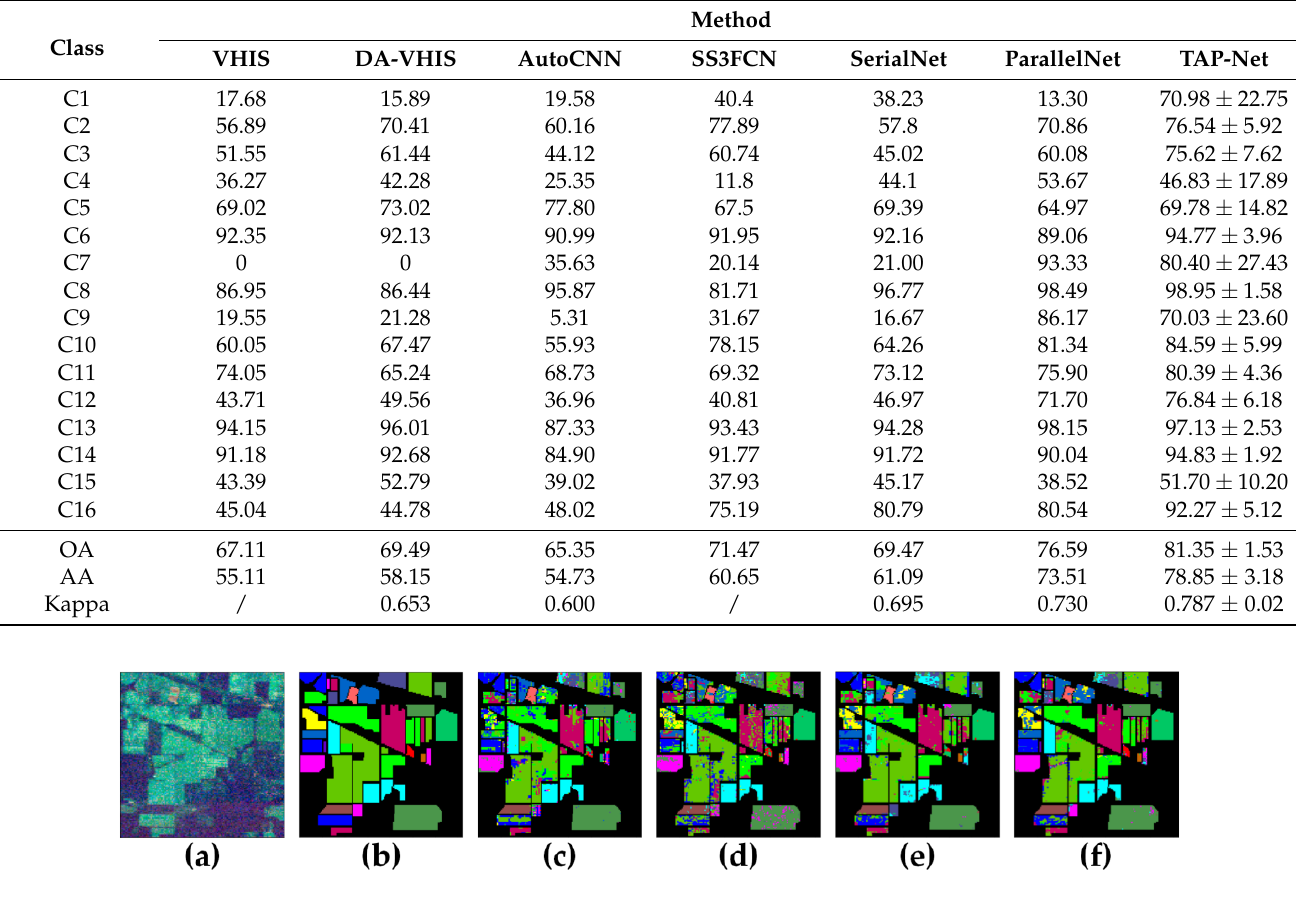
Figure 11. Classification maps of different models for Indian Pines: ( a ) false color image, ( b ) ground truth, ( c ) SS3FCN, ( d ) SerialNet, ( e ) ParallelNet, and ( f )